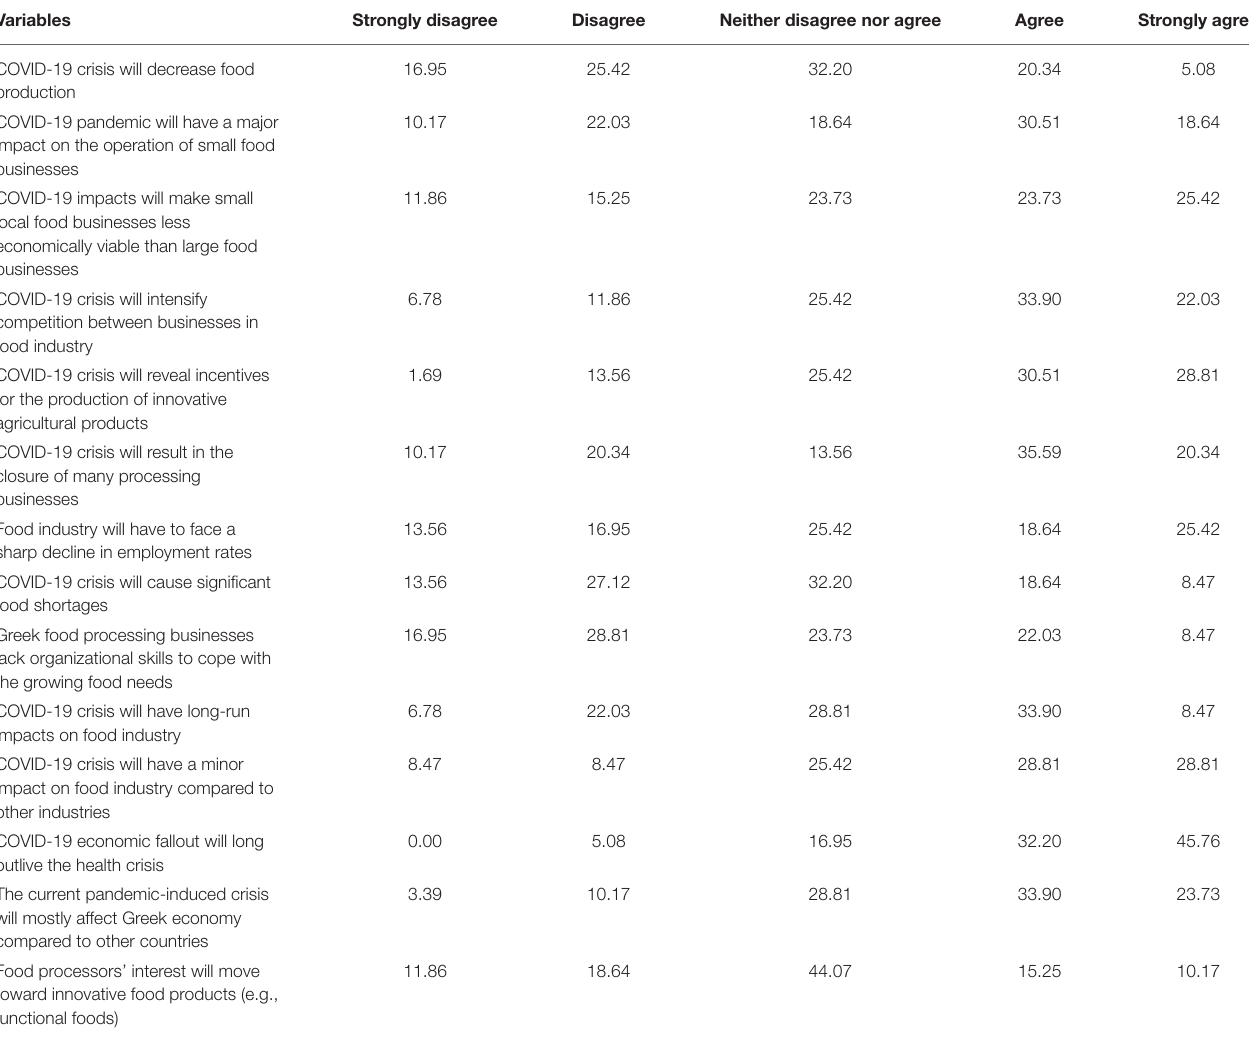
TABLE 4 | Experts’ perceptions toward COVID-19 impact on food processing businesses (%).